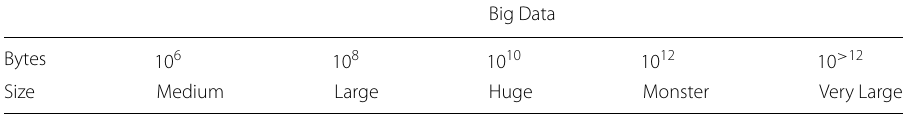
Table 1 Classification of size of data [9]